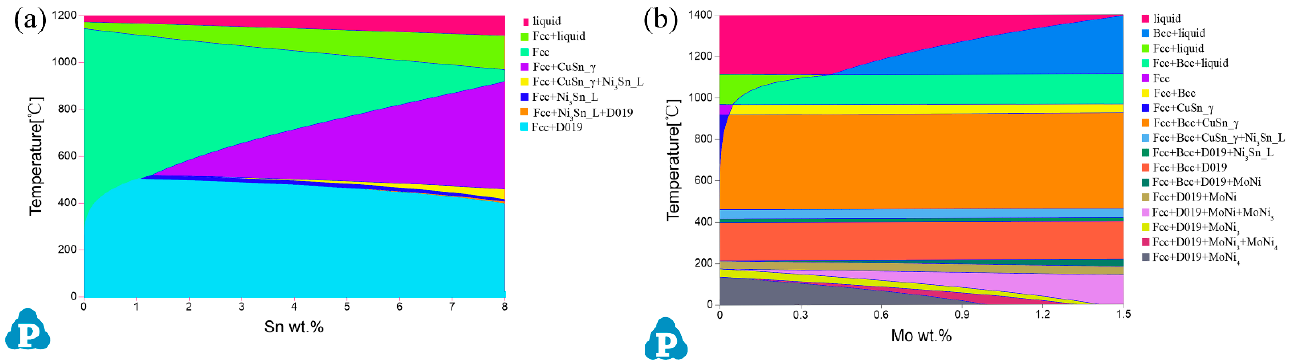
Figure 2. The simulation-calculated pseudo-binary phase diagrams of ( a ) Cu–15Ni–xSn (x = 0–8 wt.%) and ( b ) Cu–15Ni–8Sn–xMo (x = 0–1.5 wt.%) systems.